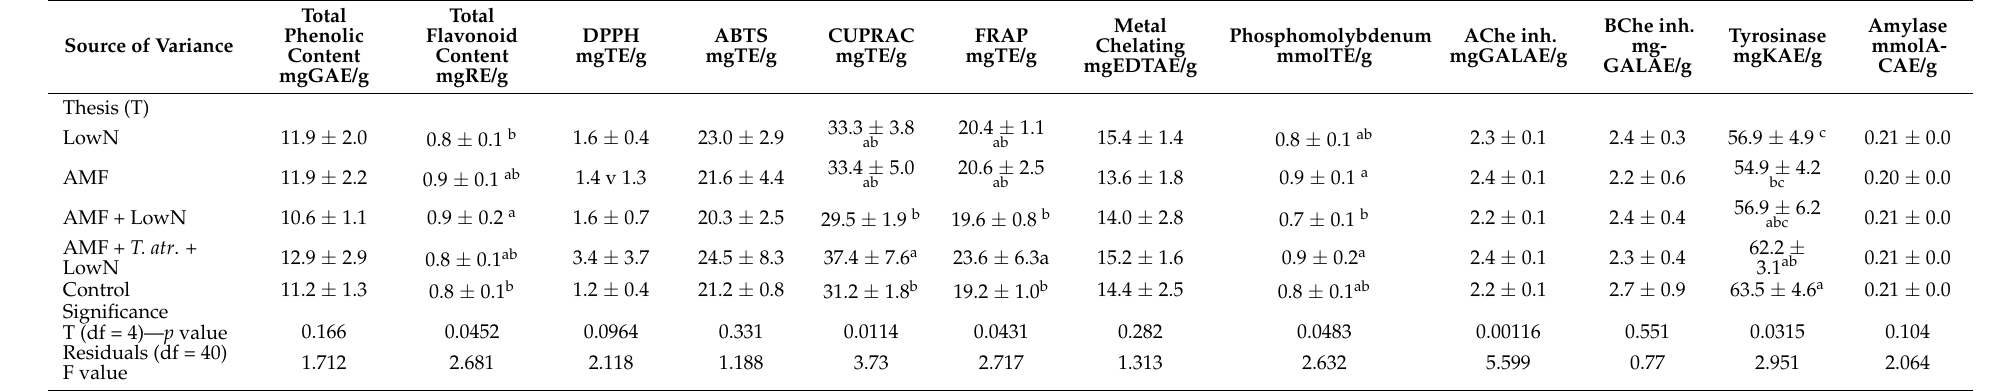
Table 5. Antioxidant assays and enzyme inhibition properties in tomato fruits from plants grown under low nitrogen fertilization regimen, treated with different biostimulants at the site with sub-optimal soil fertility. The data were elaborated by one-way analysis and Duncan test.